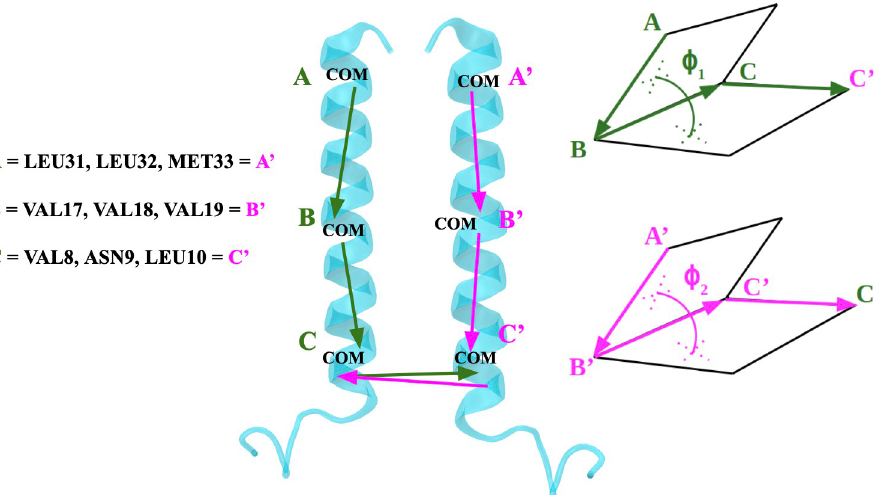
Fig 2. The definition of ϕ 1 and ϕ 2 dihedral angles. The centers of mass (COMs) of the upper (A/A’), middle (B/B’), and lower (C/C’) groups of residues were picked as the three points forming each dihedral, while the fourth point